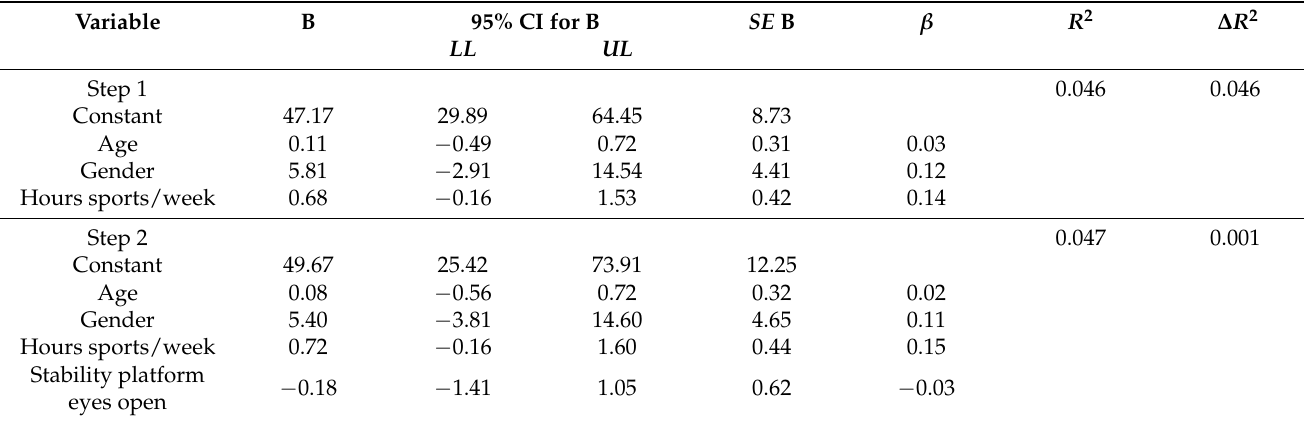
Table A2. Hierarchical regression model for the flanker effect (RT incongruent–RT congruent).